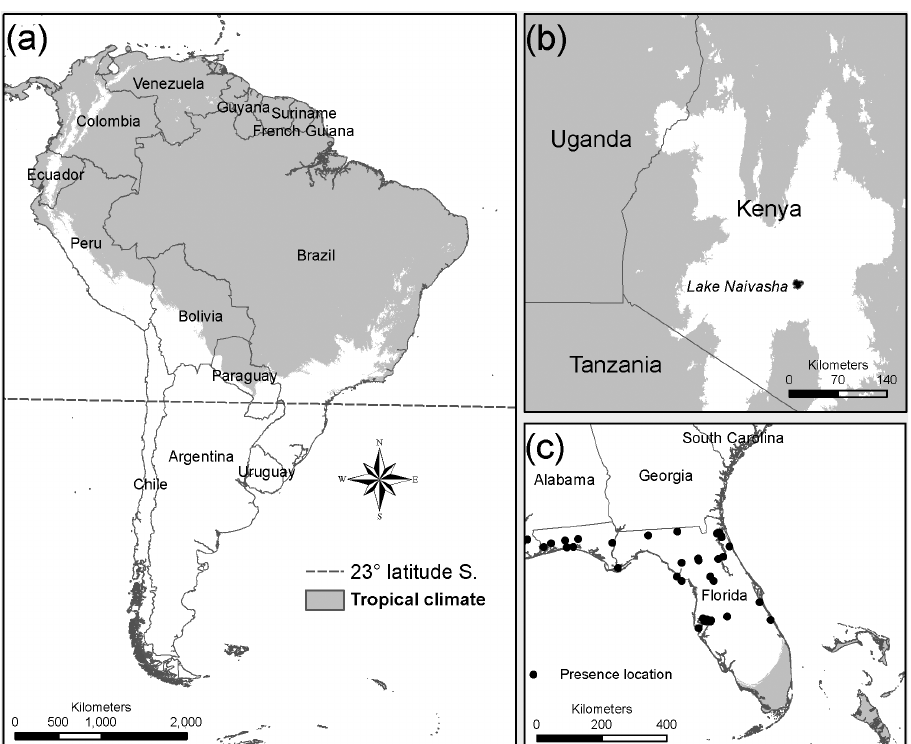
Figure 5. Tropical areas in relation to coypu presence. Areas defined as tropical are shown in a South America where coypu are native south of -23° latitude b Kenya where coypu have only been reported around Lake Naivasha, and c Florida, USA where coypu have not been reported in the southern part. Maps are in Mollweide